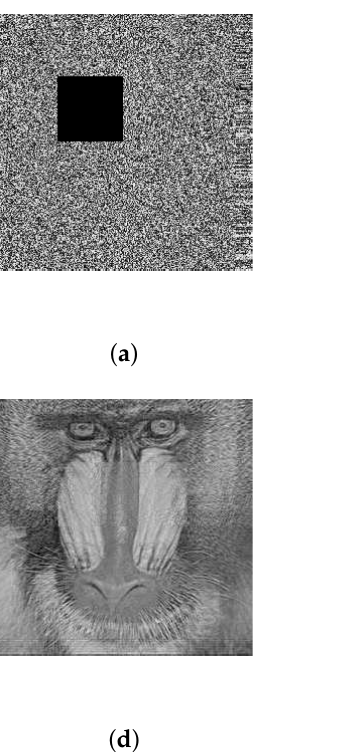
Figure 9. The cipher image of a baboon transmitted in the channel containing data loss of ( a ) 6.25%, ( b ) 25%, or ( c ) 50% and the corresponding decrypted image of the baboon containing data loss of ( d ) 6.25%, ( e ) 25%, or ( f ) 50%.